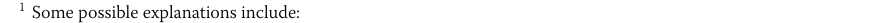
Structural break test